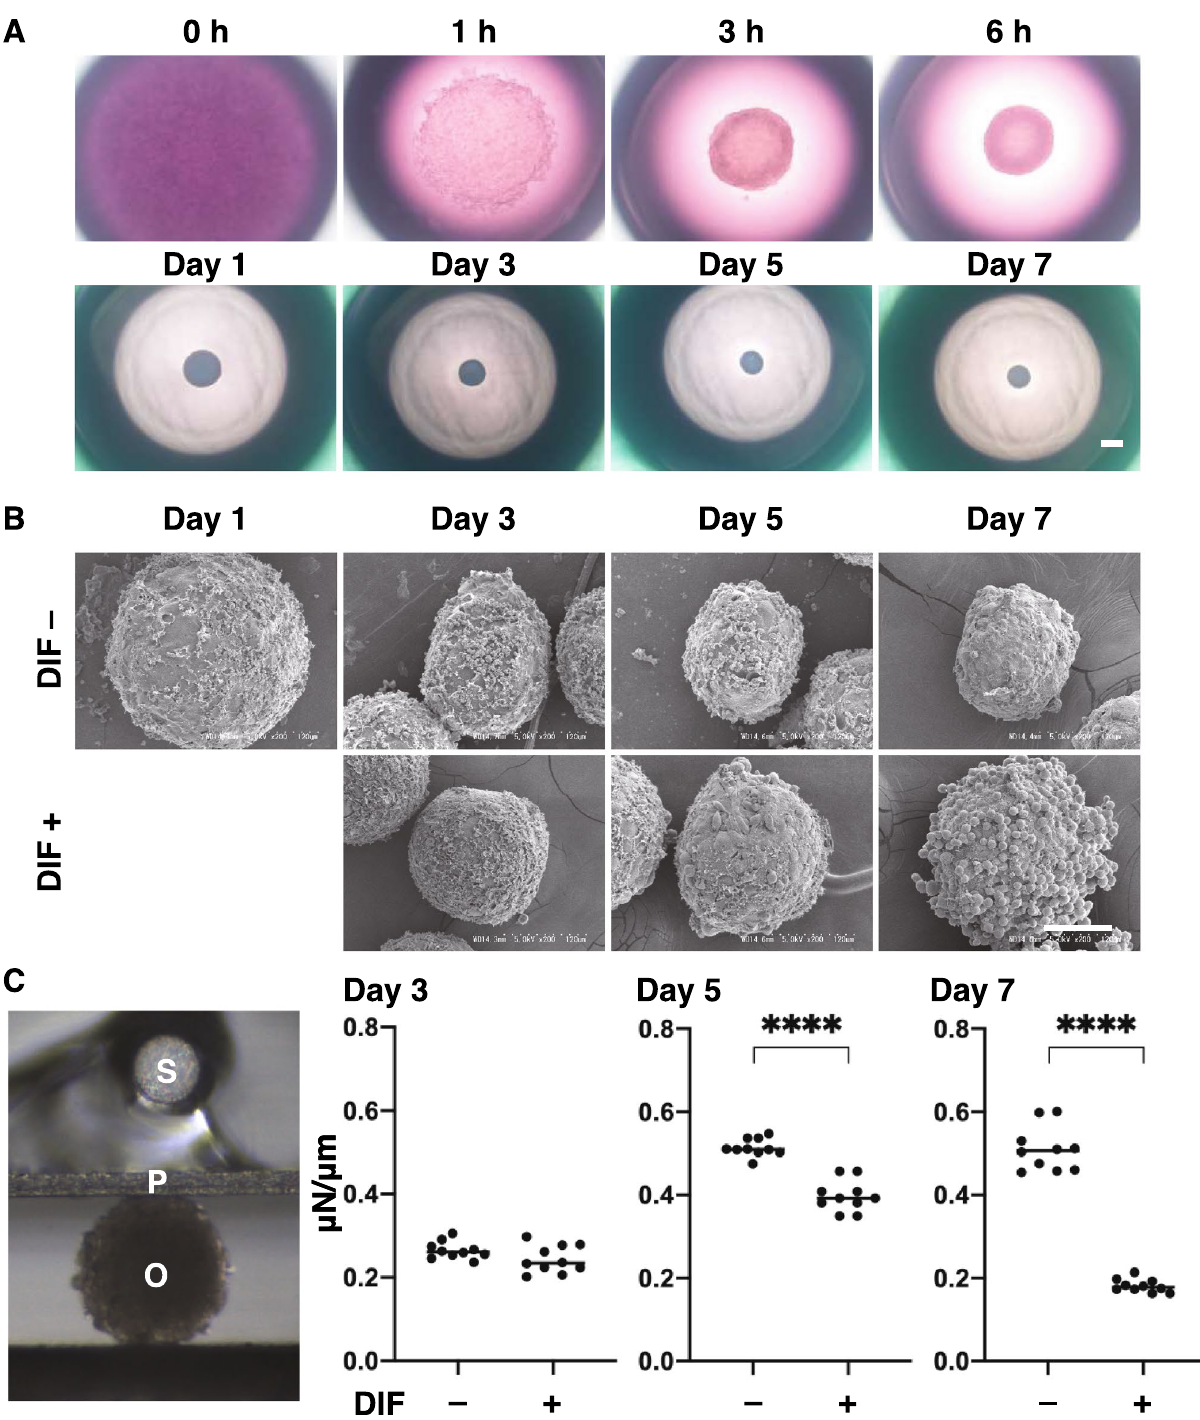
Figure 3. Characterization of the maturation process of the 3T3-L1 3D organoid with (DIF+) or without adipogenesis (DIF−). Representative phase contrast microscopy (PC) images at several time points (0, 1, 3, or 6 h, or Day1, 3, 5 or 7) of 3T3-L1 3D organoids without adipogenesis (DIF−) are shown in ( A ) (Scale bar: 100 µm). Electron microscope (EM) images at several time points (Day1, 3, 5 or 7) of the 3T3-L1 organoids without (DIF−) or with adipogenesis (DIF+) ( B , Scale bar: 100 µm). Since adipogenic differentiation was induced from Day 1, the EM image of DIF+ at Day 1 is omitted. A single 3D organoid was compressed by a micro-squeezer, and the compression process was continuously monitored by a microscopic camera ( C left, S: sensor, P: plate, O: organoid). As the physical stiffness at several time points (Day 3, 5 or 7) of 3D organoids without (DIF−) or with adipogenesis (DIF+), the force (μN) required to induce deformation until their half diameter (μm) was reached were measured, and force/displacement (μN/μm) was potted ( C right). **** P < 0.001, and other pairs were not statistically significant (ANOVA followed by a Tukey’s multiple comparison